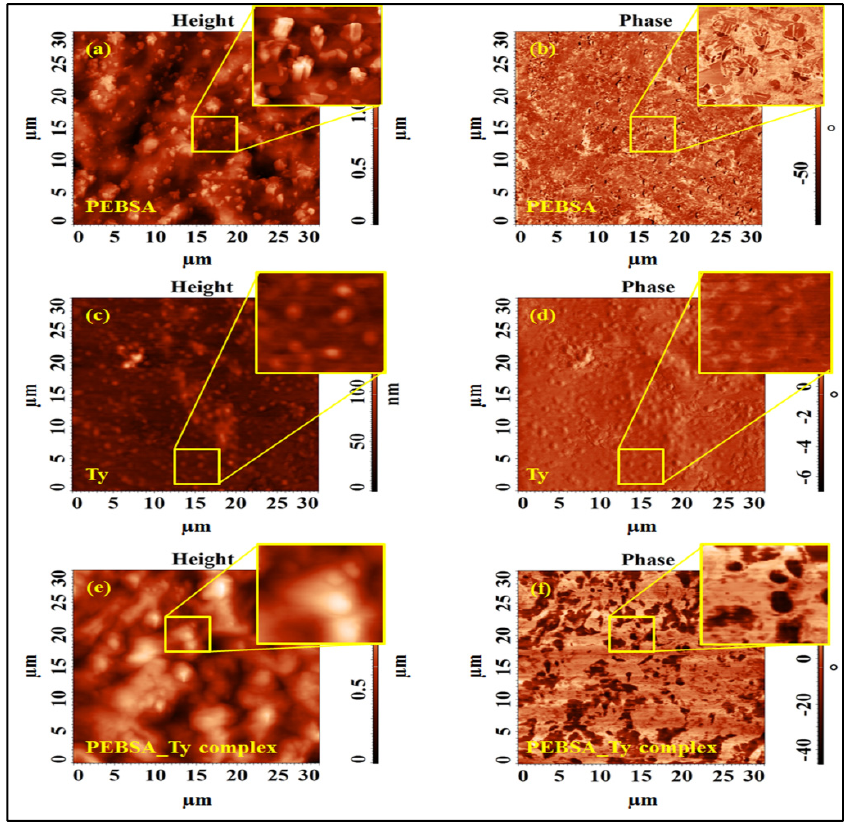
Figure 14. Bi-dimensional and phase contrast AFM images collected on PEBSA copolymer ( a , b ), thymol ( c , d ) and PEBSA-Ty complex ( e , f ).